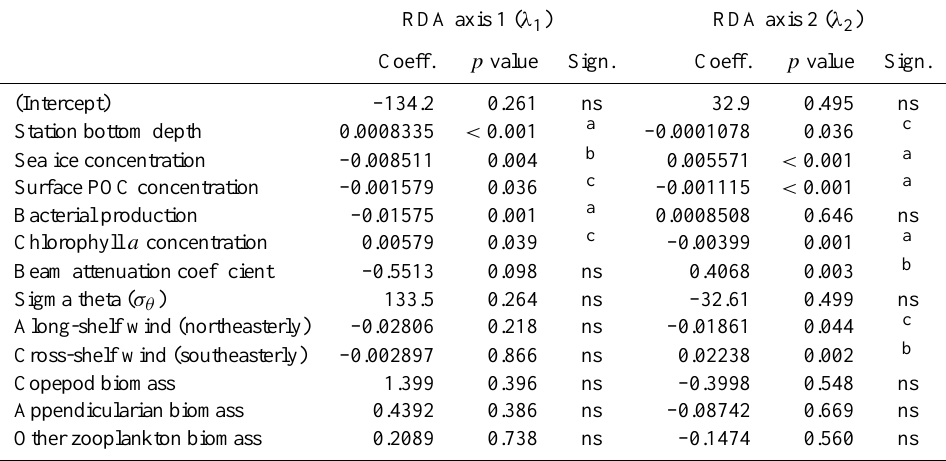
Table 4. Coefficients from the multiple linear regressions of the fitted site scores of the two significant PCNM canonical axes (representing 44.5% and 5.0% of the total PCNM variance, Fig. 15h–i) against the set of environmental and biological variables available in the present study. PCNM: principal coordinates of neighbor matrices (Borcard et al., 2011). RDA axis 1 ( λ 1 ) RDA axis 2 ( λ 2 ) Coeff. p value Sign. Coeff. p value Sign.